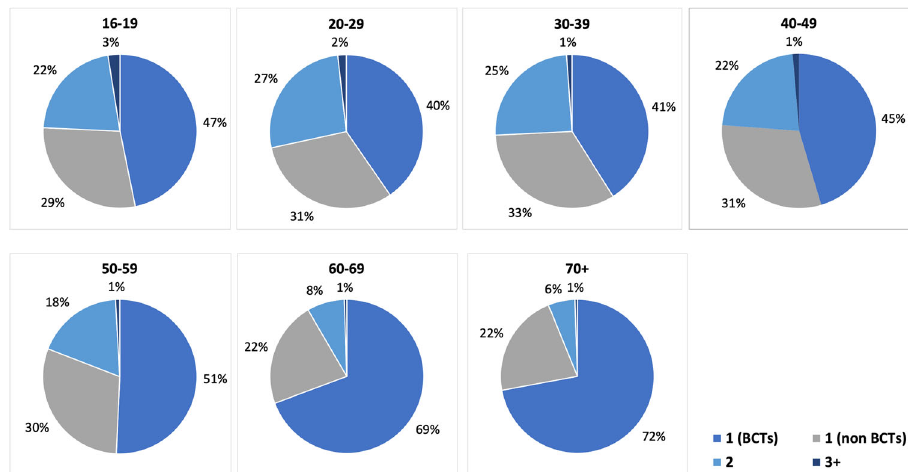
Fig. 9 Color word types with varying number of words. Percentage of the BCTs, monolexemic non-BCTs and multi-component word types in different age